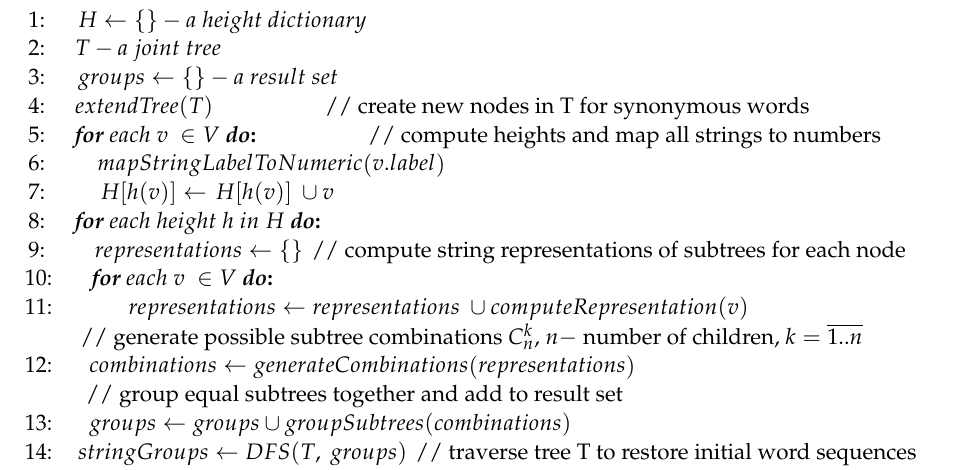
Algorithm 2: Main idea of a similar subtree search algorithm. The subtree search algorithm